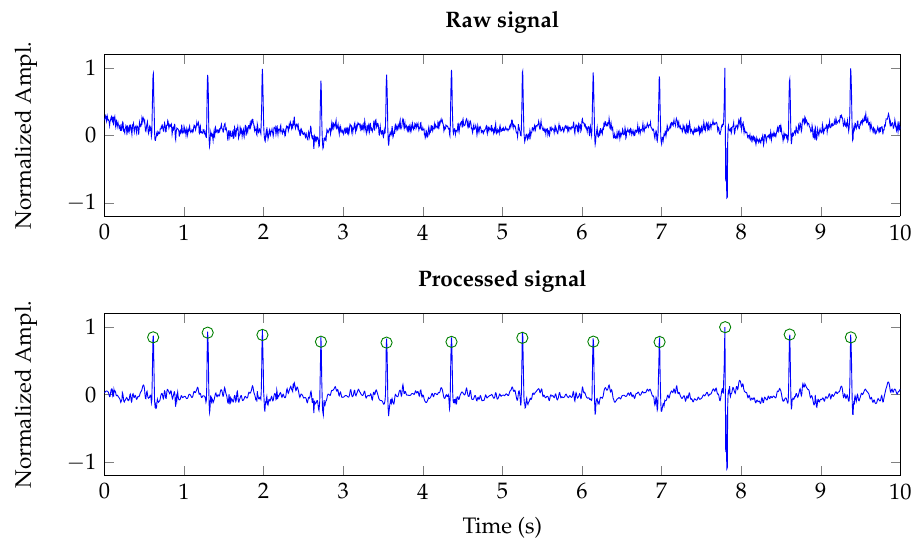
Figure 11. Raw and denoised ECG (dots correspond to detected QRS